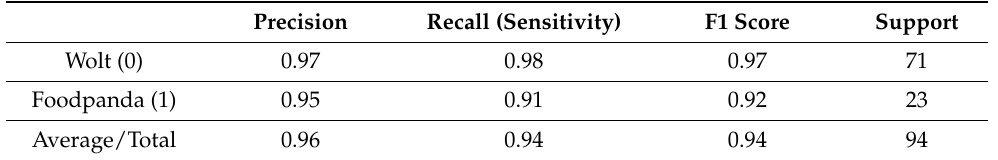
Figure 4. GMM algorithm output based on Hungary data (source: authors’ calculations based on Python programming). Table 1. Confusion matrix